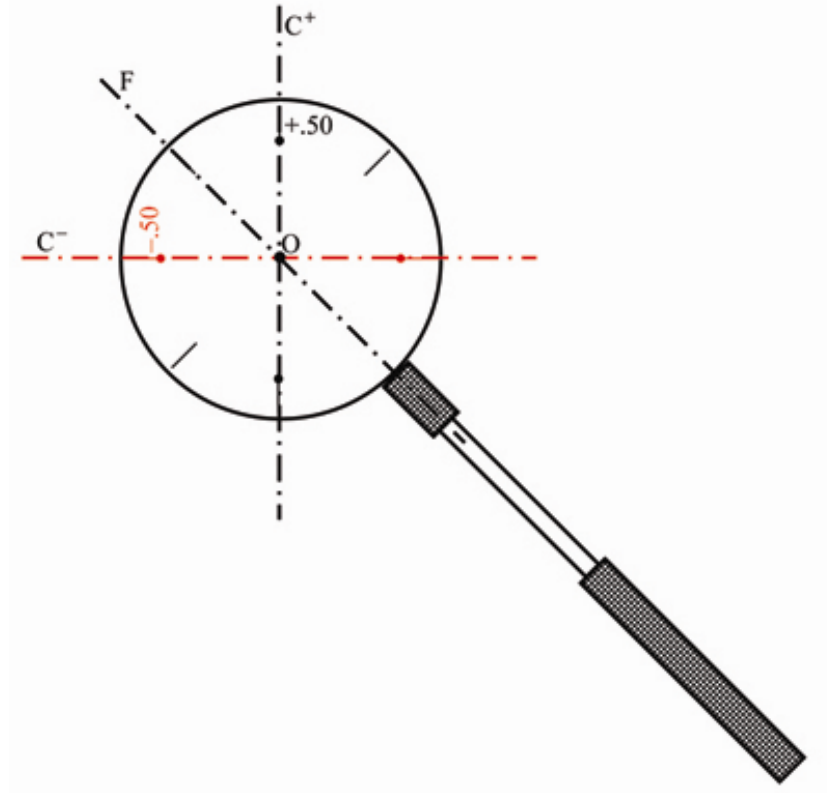
Figure 5 Four axes of the Jackson cross-cylinder. F is the flip axis; it is defined by the handle and lies in the plane of the figure. O is the optical axis; it is orthogonal to the plane of the figure and through the geometrical centre of the lens. C + is the axis of the positive cylinder (vertical here) and C ¯ the axis of the negative cylinder of the equivalent bicylindrical form; the two axes are just over 1 m behind and parallel to the plane of the figure. Stokes’s astigmatic axis is C + except that it lies in the plane of the